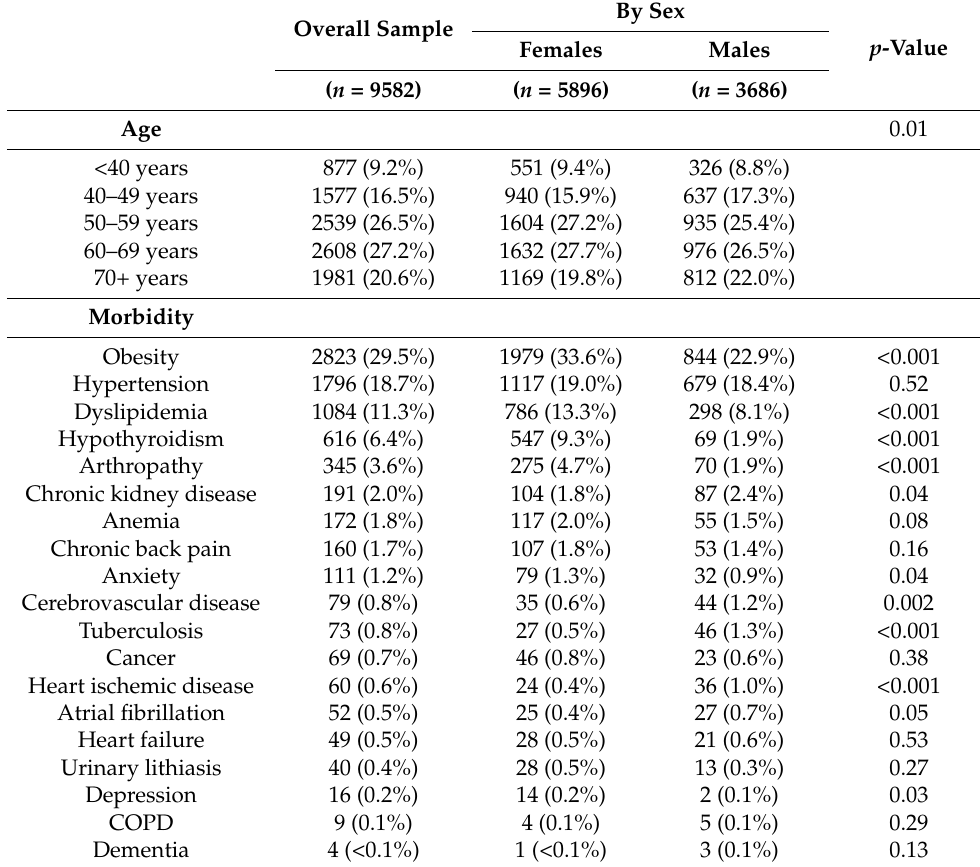
Table 1. Morbidities distribution among T2DM individuals: overall and by